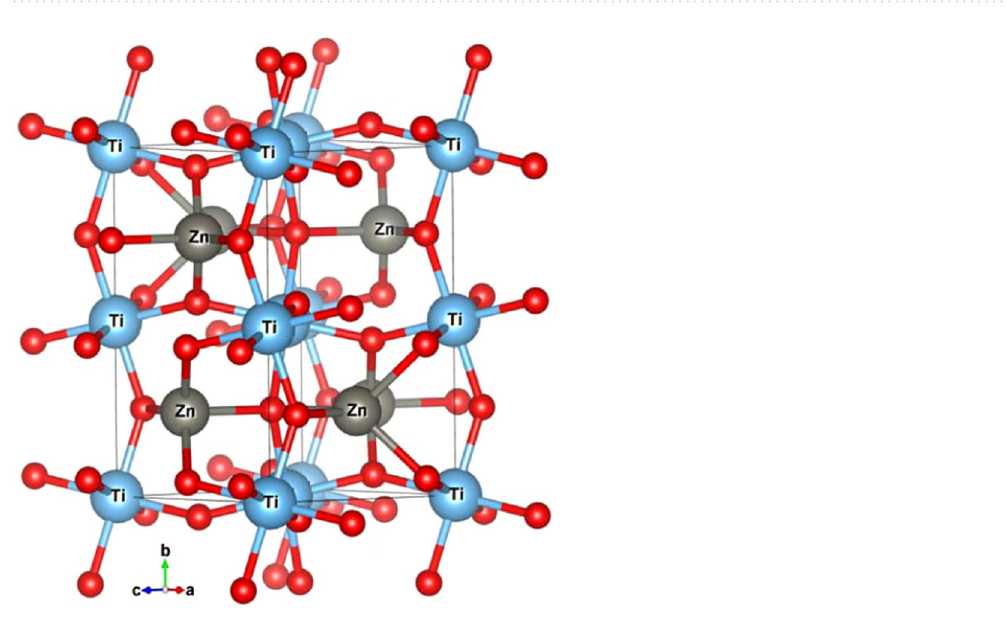
Figure 2. A view of the crystal structure of perovskite(Pv)-type ZnTiO 3 (space group Pnma) along the